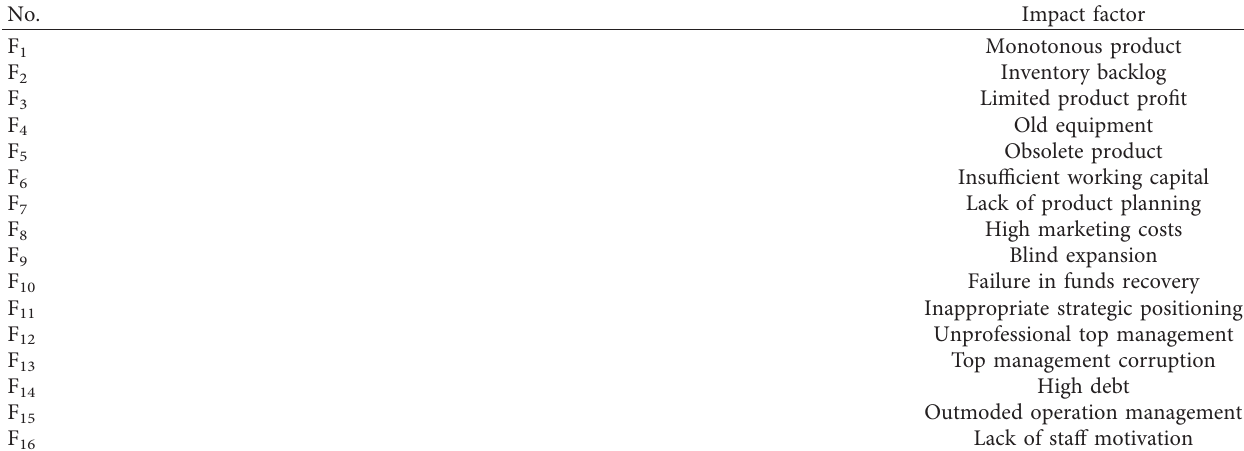
Table 2: Element identification.